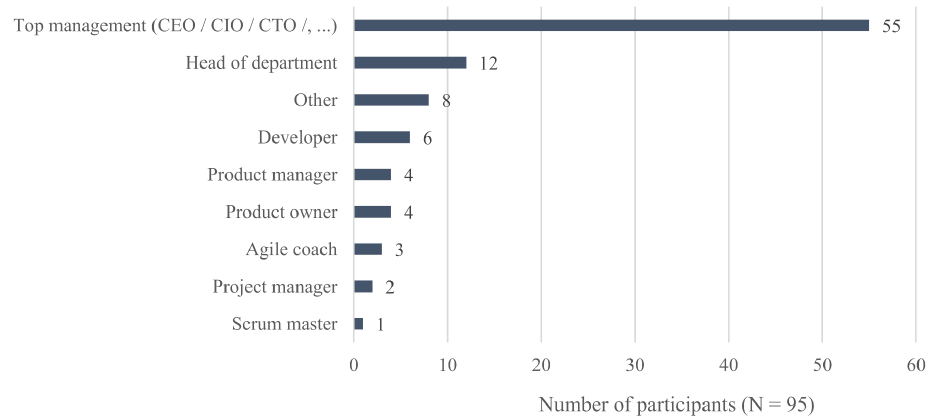
Figure 3. Roles of the survey participants.